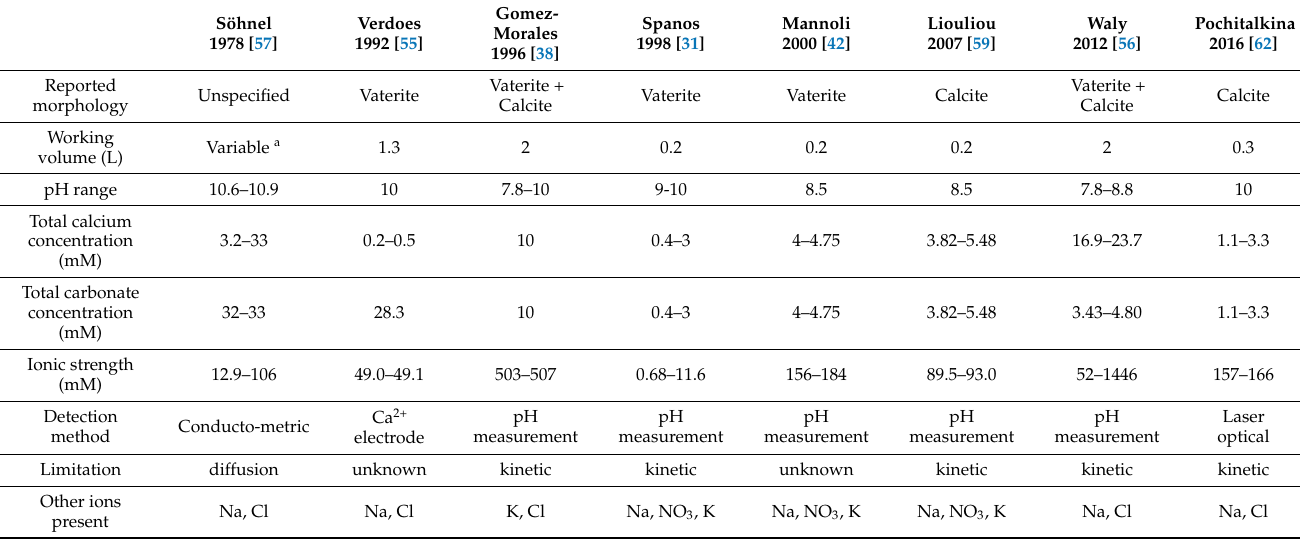
Table 3. Experimental details of studies on the nucleation of calcium carbonate.